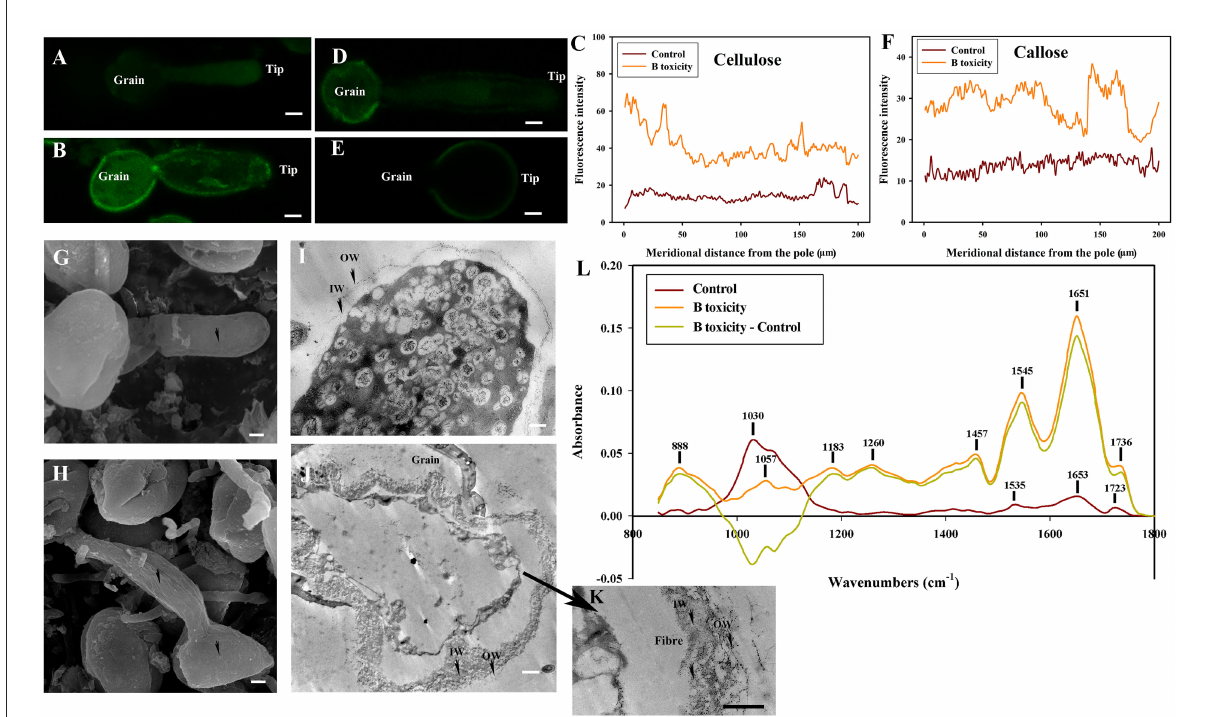
FIGURE8 Effects of B toxicity on cell wall architecture treated with β -1,3-glucanase treatment. (A) Cellulose in control pollen tube digested with β -1,3-glucanase indicated by CBM3a labeling. (B) Cellulose in B toxicity-treated pollen tube digested with β -1,3-glucanase. (C) Quantitative analysis of the fluorescent intensity of cellulose in the wall of control (Control) and B toxicity-treated pollen tubes, which were digested with β -1,3-glucanase. (D) Callose in control pollen tube indicated by monoclonal antibody to (1 → 3)- β -glucan labeling digested with β -1,3-glucanase. (E) Callose in B toxicity-treated pollen tube digested with β -1,3-glucanase. (F) Quantitative analysis of callose fluorescent intensity in the wall of control (Control) and B toxicity-treated pollen tubes which were digested with β -1,3-glucanase. (G) SEM of control pollen tube digested with β -1,3-glucanase. (H) SEM of B toxicity-treated pollen tube digested with β -1,3-glucanase. (I) TEM transverse section of control pollen tube digested with β -1,3-glucanase. A thin fiber pectin layer in OW of control pollen tubes was observed and the IW was difficult to be observed with β -1,3-glucanase. (J,K) TEM transverse section of pollen tube treated with β -1,3-glucanase. After β -1,3-glucanase treatment, the fiber pectin layer in OW was observed with a thin layer, but the IW of B toxicity-treated pollen tubes was still thick, and there were still some fibers crosslinked with the callose layer to form an irregular crosslinking layer. (L) FTIR spectra from the tip regions of C . mollissima pollen tubes digested with β -1,3-glucanase (control pollen tube: Control), B toxicity-treated pollen tubes treated with β -1,3-glucanase and the FTIR differential spectrum (B toxicity – control) generated by digital subtraction of the control spectra from B toxicity-treated spectra digested with β -1,3-glucanase. Bar = 10 µ m in (A,B,D,E) . Bar = 3 µ m in G and H; Bar = 2 µ m in (I,J) . Bar = 1 µ m in K. OW, Outer wall; IW, inner wall. The arrows showed the smooth surface (G) and the uneven surface (H)